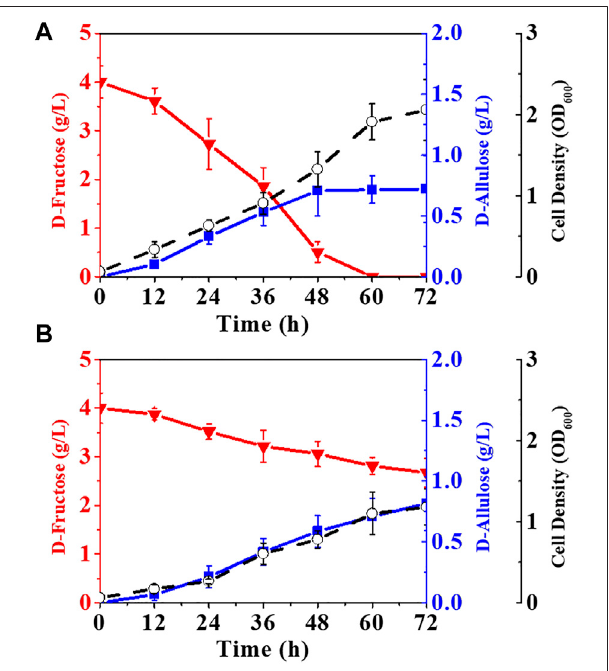
FIGURE 5 | Elimination of the pathways phosphorylating fructose-6- phosphate. E. coli cells were cultured in LB medium with 4.00 g/L D-fructose and 100 mM potassium phosphate at 37 ° C. (A) E. coli ( alsE , a6PP , ptsG - F , mak , Δ fruA , Δ pfkA ), (B) E. coli ( alsE , a6PP , ptsG - F , mak , Δ fruA , Δ pfkA , Δ pfkB ). Error bars, SD , n = 3